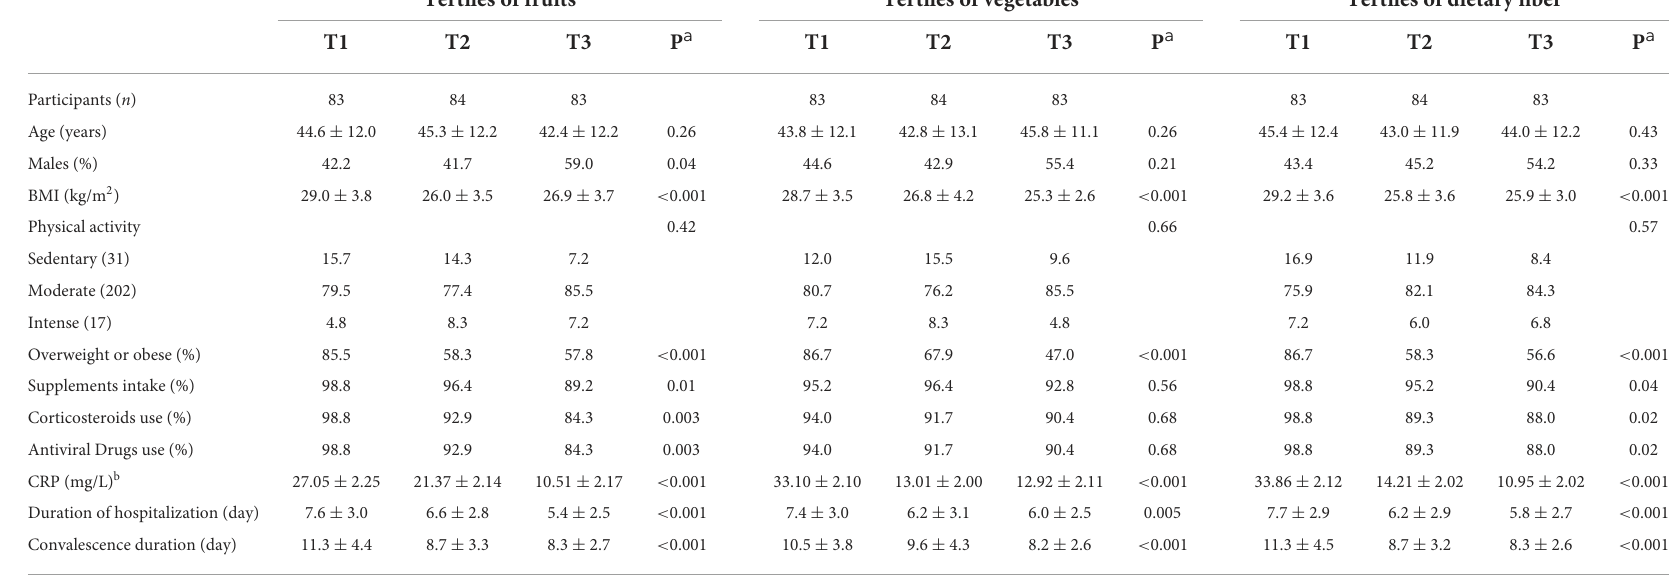
TABLE 1 Demographic characteristics of the study participants across tertiles of dietary fruits, vegetables, and